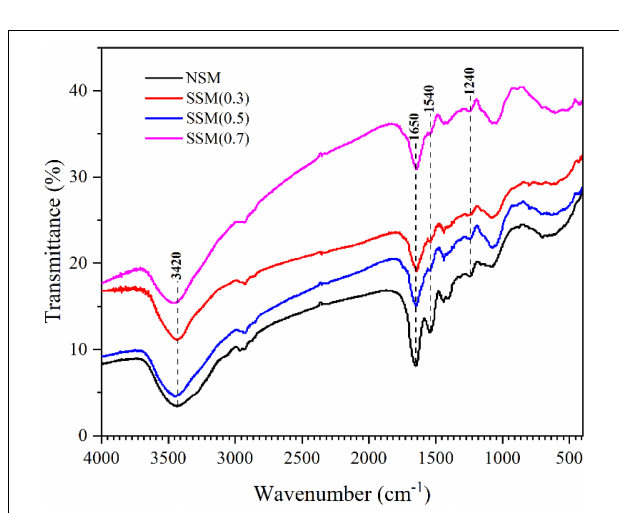
FIGURE 4 | The infrared spectrum information of soybean meal protein. NSM, native soybean meal; SSM, steam-exploded soybean meal, SSM (0.3), SSM (0.5), and SSM (0.7) indicated steam explosion pressure were 0.3, 0.5, and 0.7 MPa, respectively.